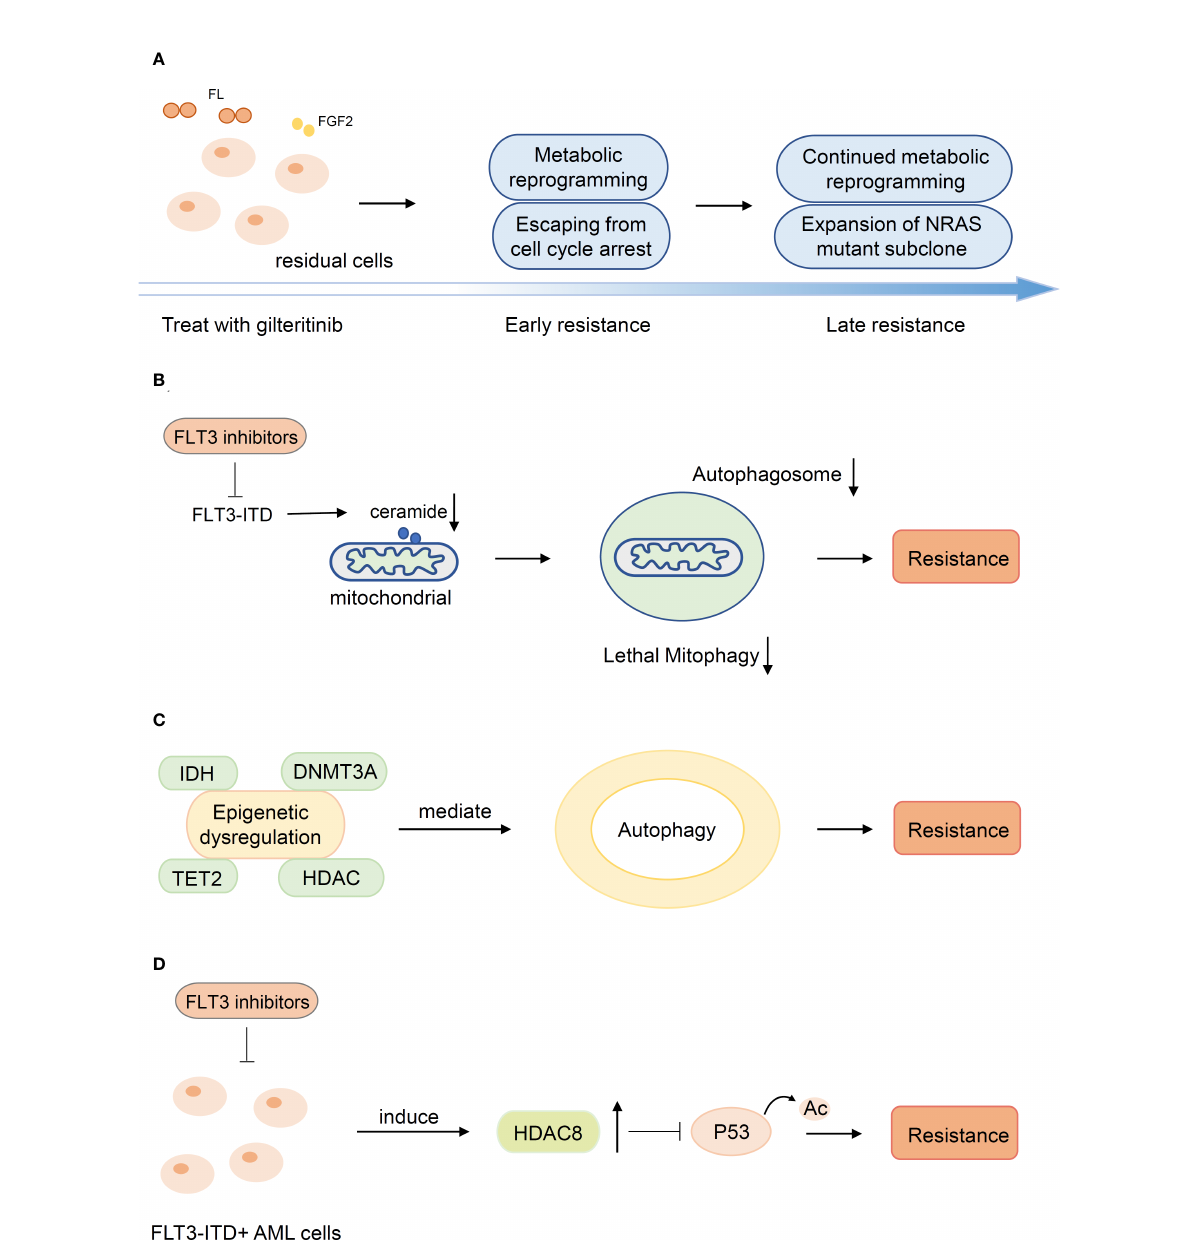
FIGURE 3 Other mechanisms of secondary resistance. (A) Metabolic reprogramming mediated the evolution of resistance. (B) The abnormality of mitochondrial ceramide results in resistance to FLT3-inhibitors by arresting mitophagy. (C) Mutations in epigenetic modi fi cation genes suggests potential associations between alterations and autophagy associated with secondary resistance (D) HDAC8 was upregulated upon FLT3 inhibitor exposure and enhanced HDAC8 binding and deacetylation of p53 to promote